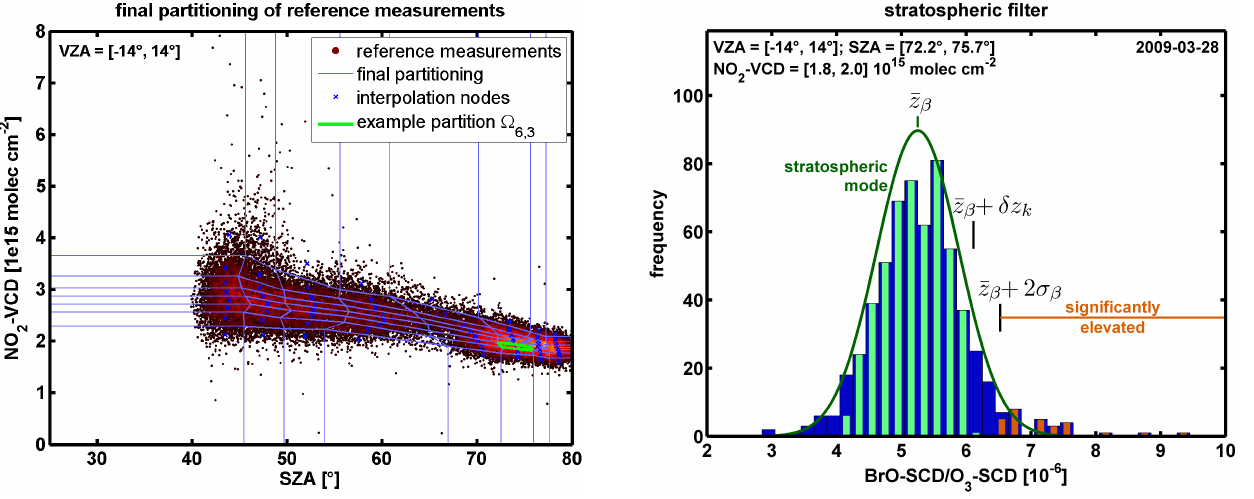
Fig. 4. Frequency distribution of measured BrO SCD to O 3 SCD ratios (blue) from the example partition (cid:127) 6 , 3 in Fig. 3. The algo- rithm retrieves the limits of a subdivision with minimal asymmetry (green) containing mostly measurements of the stratospheric back- ground. Significantly enhanced measurements (high BrO, low O 3 ) appear in the right tail of the distribution (red). See text for